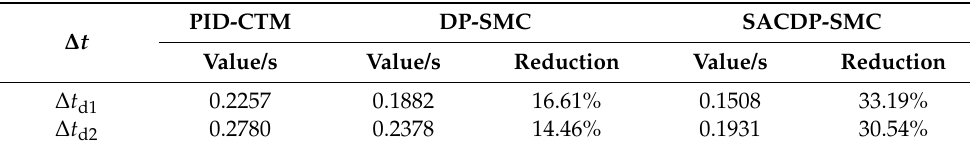
Table 6. The adjusting time of the three control methods.